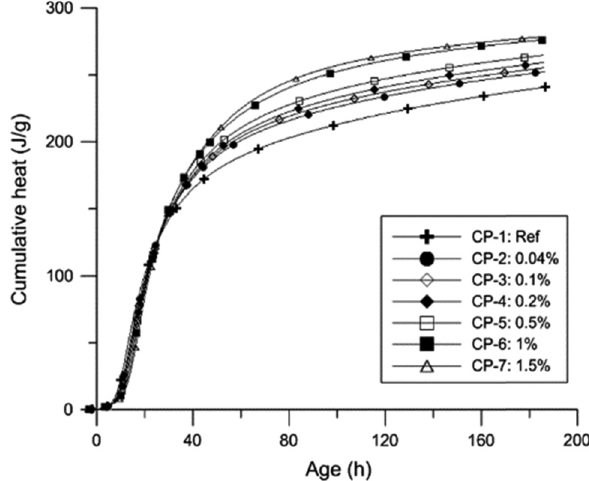
Figure 28: Cumulative heat fl ow curves of the cellulose nanocrystal - cement pastes at di ff erent CNC concentrations, reprinted with per - mission from ref. [ 42 ] ; Copyright 2015, Elsevier. Note: Figure 19a in Section 3.5 shows the heat fl ow